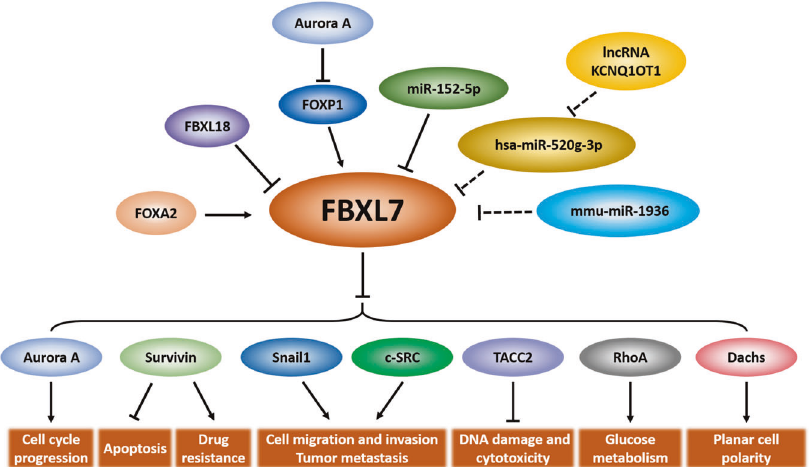
Fig. 2 The upstream regulatory factors and the downstream substrates of FBXL7. FBXL7 is regulated by several upstream factors and targets various substrates for ubiquitination and degradation to regulate multiple biological processes. Dashed lines: The lncRNA KCNQ1OT1- hsa-miR-520g-3p axis and mmu-miR-1936 are predicted to regulate FBXL7 by bioinformatic analysis, which requires further experimental con fi